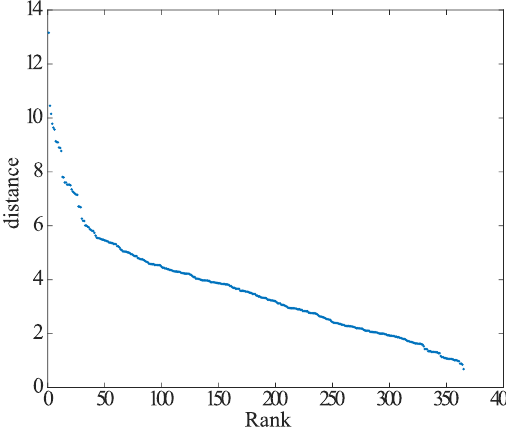
Figure 2. K-dist graph.